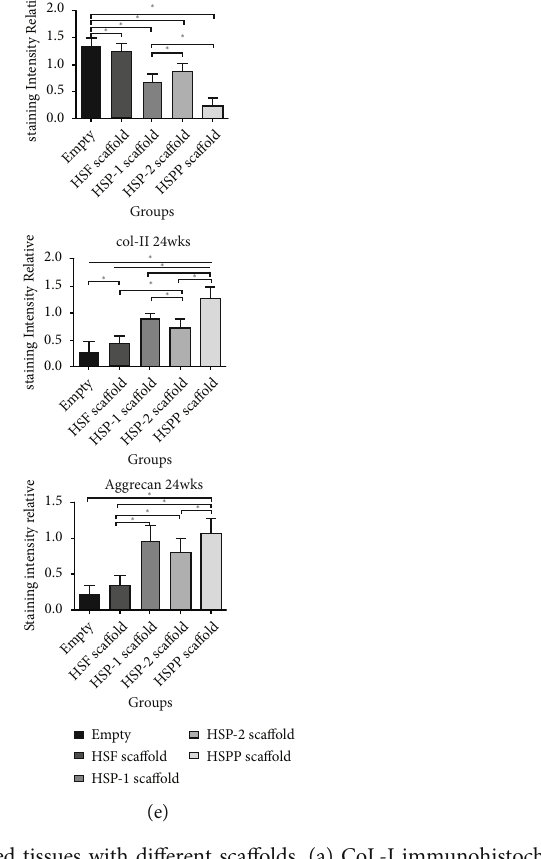
Figure 11: Immunohistochemical results of repaired tissues with di ff erent sca ff olds. (a) CoL-I immunohistochemical staining. (b) Col-II immunohistochemical staining. (c) Aggrecan immunohistochemical staining. Relative expression of CoL-I, Col-II, and Aggrecan in di ff erent groups at (d) 12 weeks and (e) 24